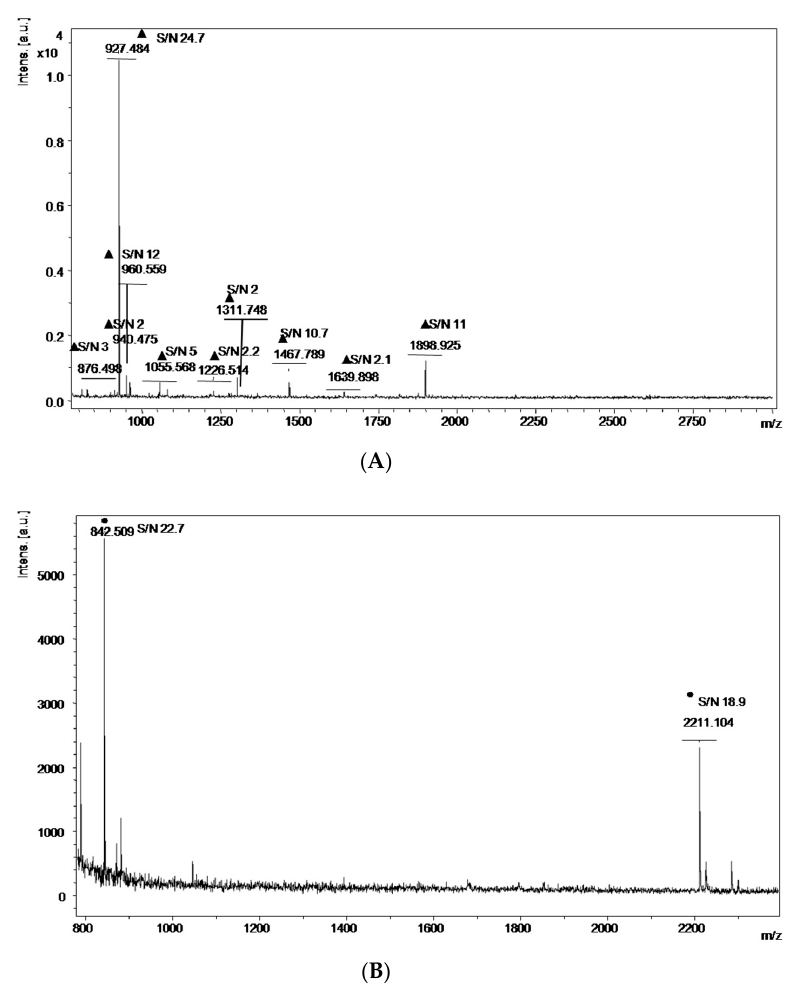
Figure 7. MALDI MS spectra of objects captured onto the SuccBB-activated AFM substrate surface. ( A ) C HSA = 10 − 9 M; ● , trypsin autolysis peaks; ▲ , HSA peptides; S/N, signal-to-noise ratio. ( B ) Control solution without protein: ● , trypsin autolysis peaks. The average square deviation is <150 ppm. S/N, signal-to-noise ratio.